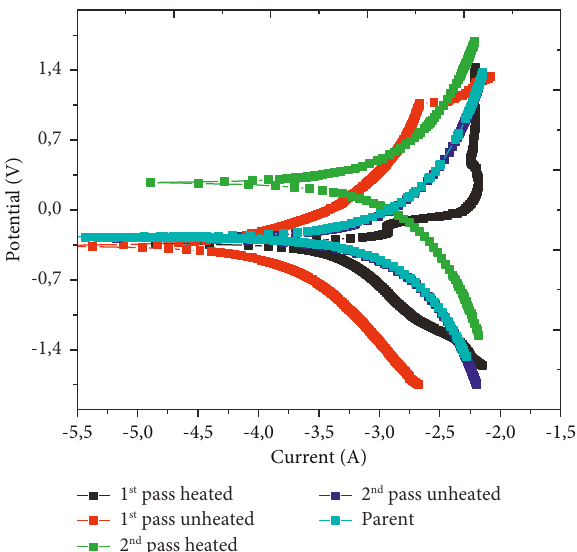
Figure 9: Tafel polarization graphs of copper samples post-ARB testing and dipped in NaCl